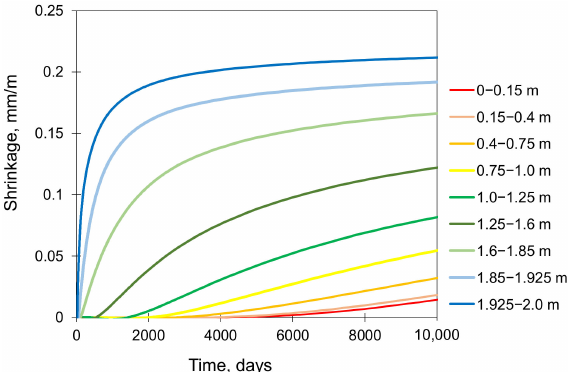
Figure 10. Potential drying shrinkage in the successive layers along with the slab